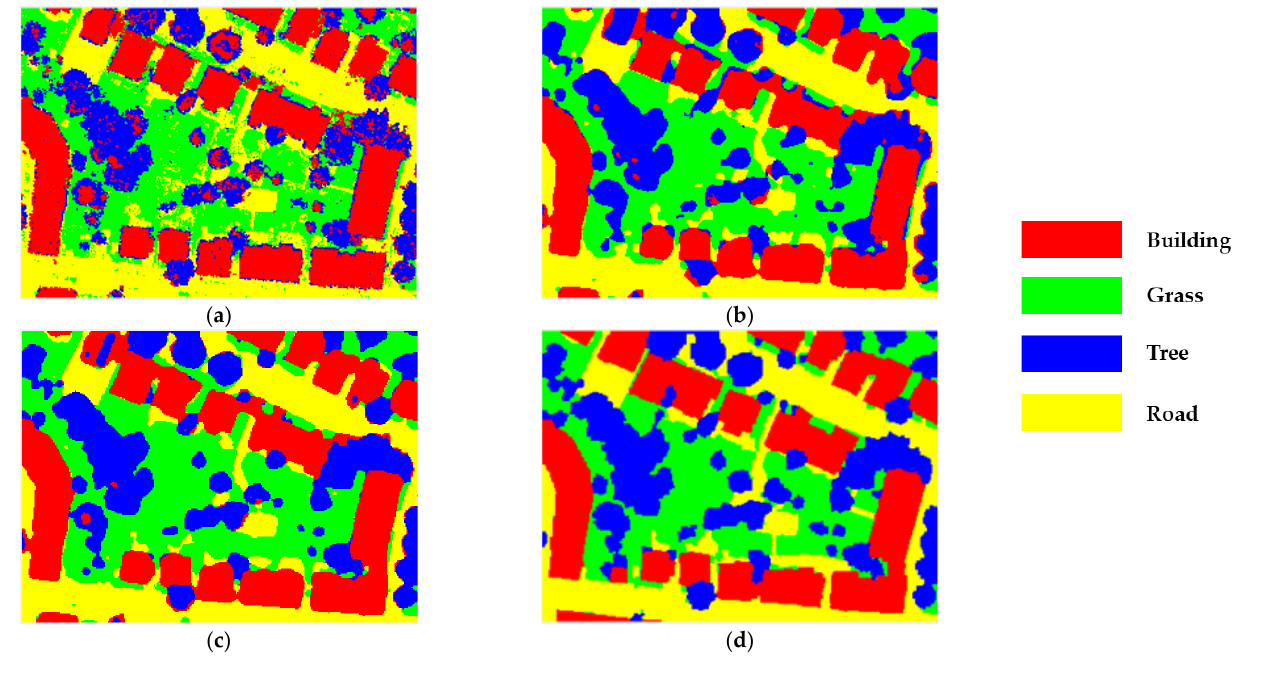
Figure 12. The land cover map of test set 2: ( a ) DS; ( b ) F-DS-FH; ( c ) the proposed method P-DS; ( d ) ground truth. Table 6. Classification accuracy (%) for land cover classes on test set 1.